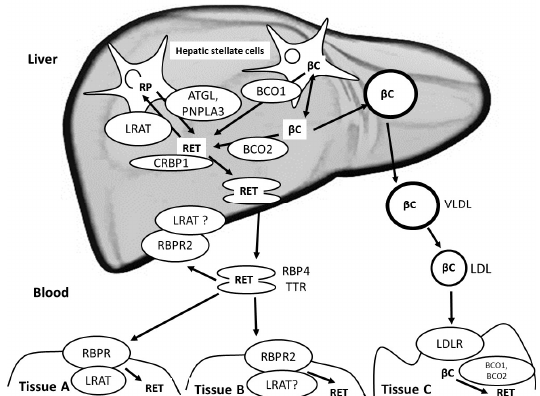
Figure 3. Proteins involved in the liver metabolism of vitamin A. ATGL: adipose triglyceride lipase;